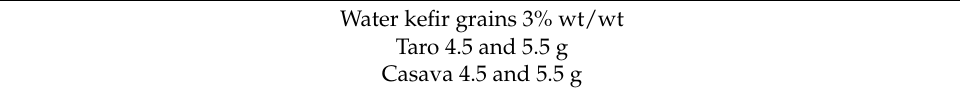
Table 2. Main conditions for the preparation of films